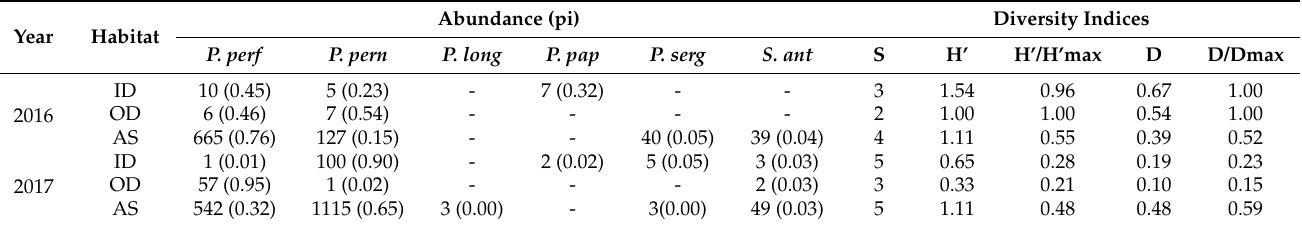
Table 3. Diversity of Phlebotominae sandfly fauna according to the sampling period and